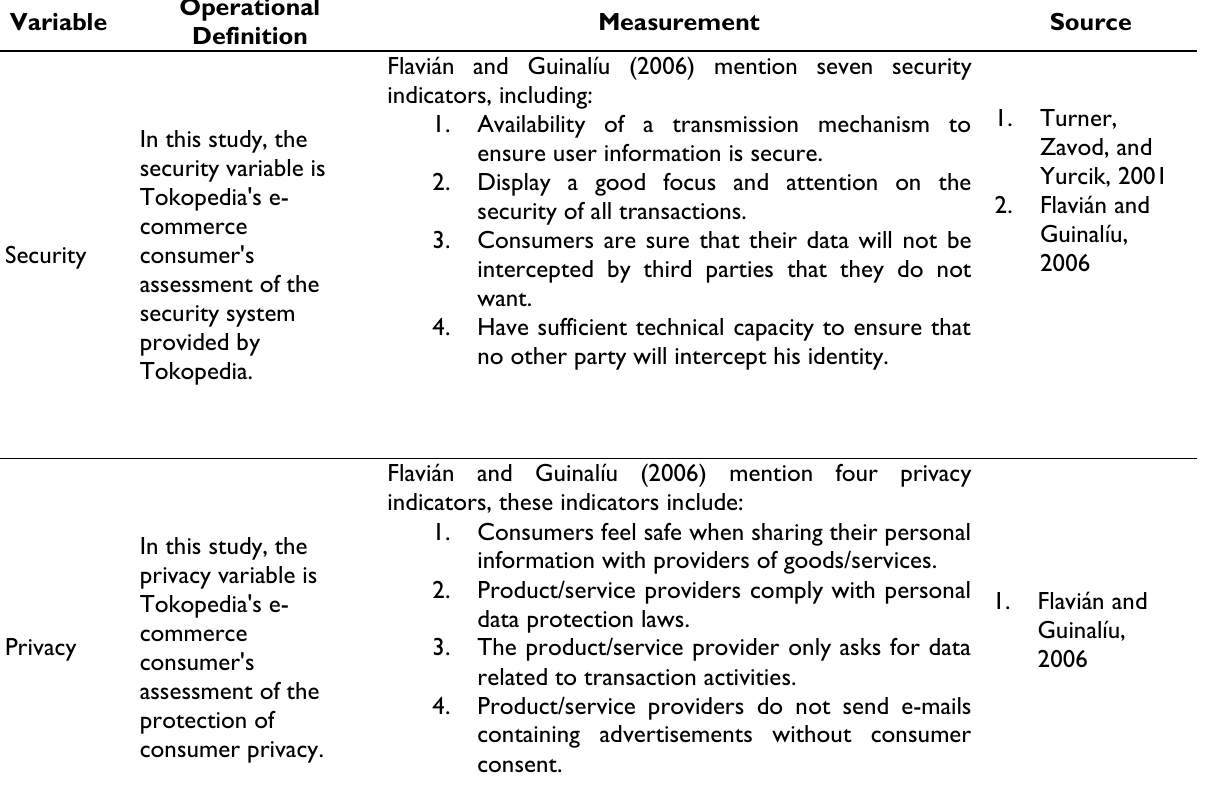
Table 1. Operational Definition of The Variables Variable